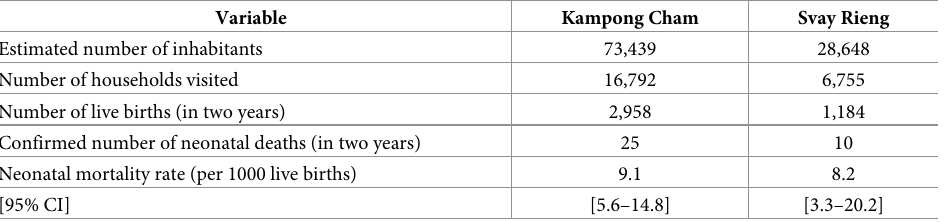
Table 1. Process of identification of live births and neonatal deaths in years 2015 and 2016 in Kampong Cham and Svay Rieng provinces. Variable Kampong Cham Estimated number of inhabitants 73,439 Number of households visited 16,792 Number of live births (in two years) 2,958 1,184 Confirmed number of neonatal deaths (in two years) 25 Neonatal mortality rate (per 1000 live